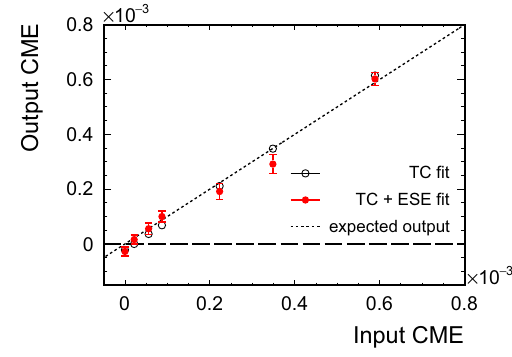
Fig. 5 The (cid:2)γ CME parameter from the TC and TC+ESE fits versus the input CME signal